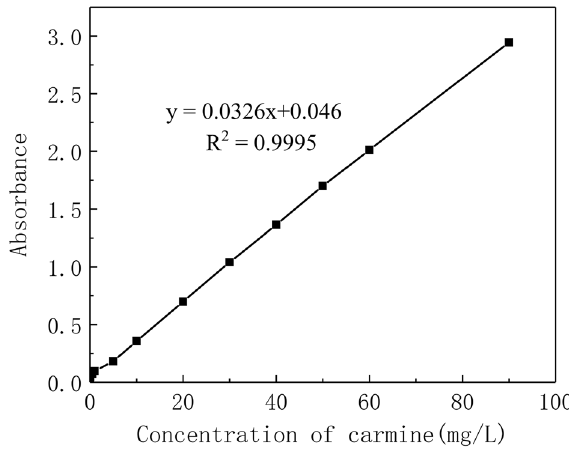
Figure 2. The standard curve of dye solution